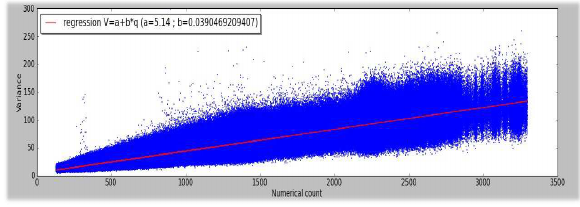
Figure 12. Estimation of parameter b for the PA band